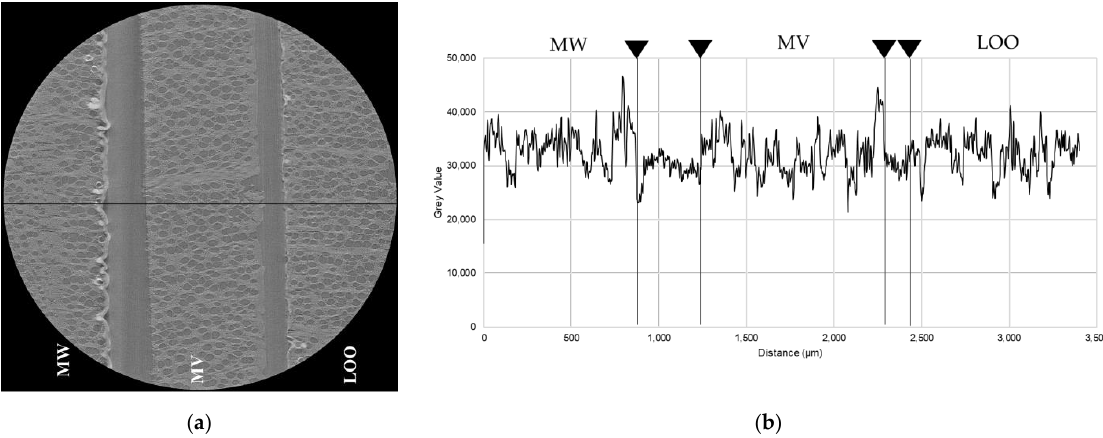
Figure 8. Sample Series 2 Cu target up side (MW, MV, LOO); ( a ) visualization result and the plot profile line; ( b ) plot profile graphic.